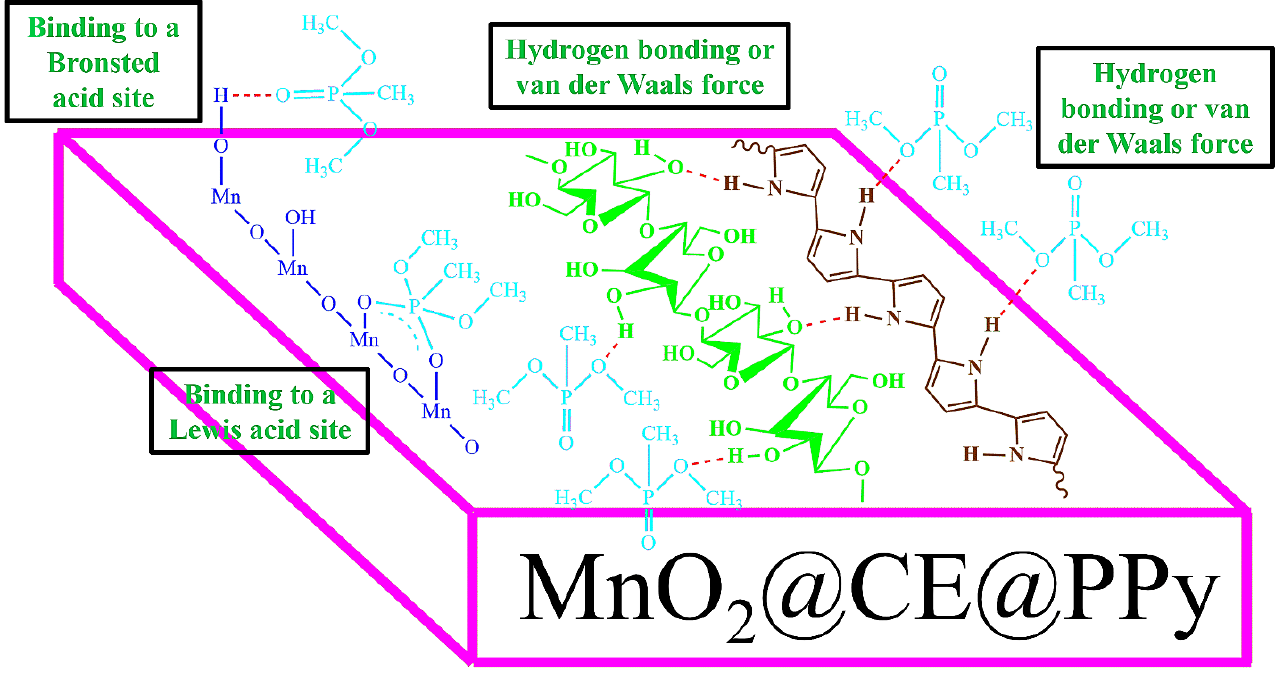
Figure 13. Proposed sensing mechanism of MnO 2 @CE/PPy with the DMMP. The figure is not to scale.